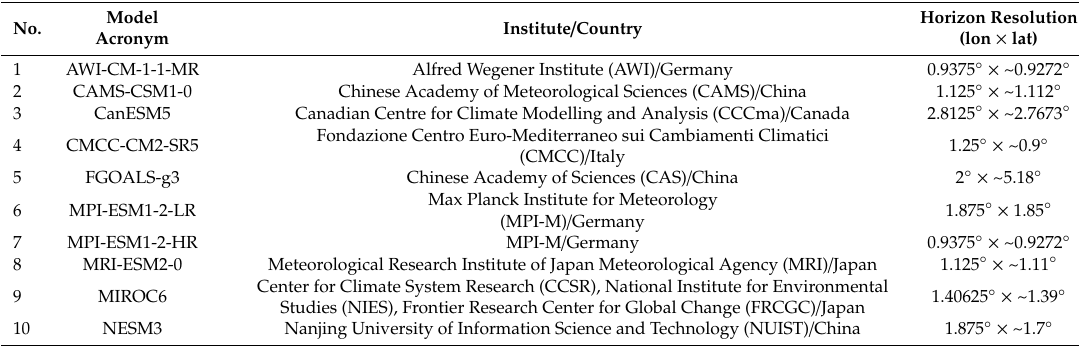
Table1. Modelacronyms, institutions, andhorizontalresolutionsoftheCoupledModelIntercomparison Project (CMIP6) models used in this